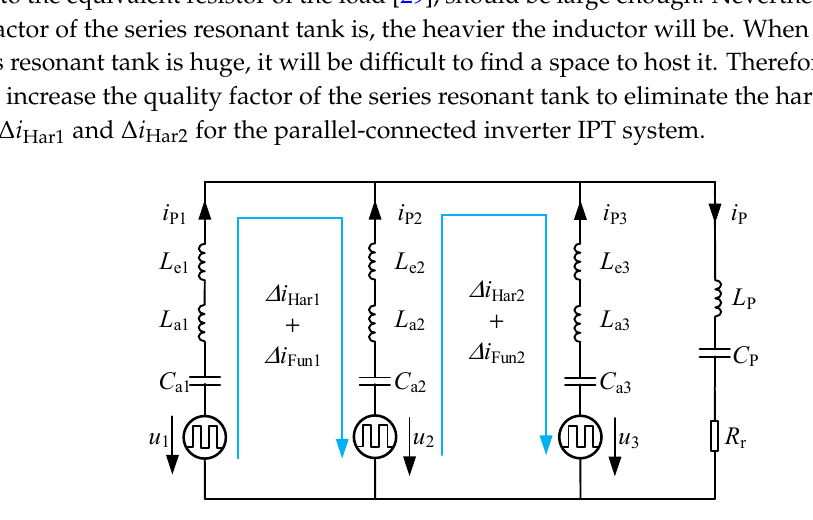
Figure 4. The equivalent circuit of the IPT system with the series resonant tank.